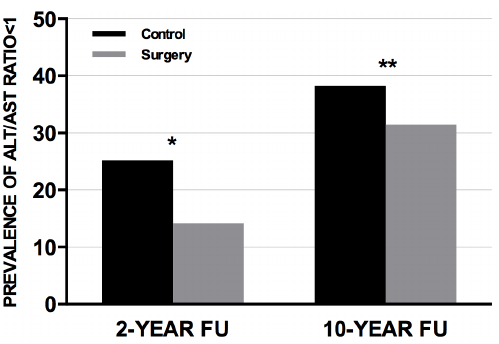
Figure 4. Prevalence of ALT/AST ratio , 1 in the surgery and the control groups at 2- and 10-year follow up. The prevalence of ALT/AST ratio , 1 is expressed as proportion of individuals. The differences in the prevalence of ALT/AST ratio , 1 between the control and the surgery group has been analyzed by Fisher’s exact test. Prevalence of ALT/AST ratio , 1 was: 25% (n=368, control group) and 14% (n=231, surgery group) at 2-year follow-up; 38% (n=381, control group) and 31% (n=366, surgery group) at 10-year follow-up. *P value , 0.001, surgery vs. control group. **P value=0.001, surgery vs. control group. Abbreviations : ALT, alanine transferase; AST, aspartate trans- ferase; FU, follow up.